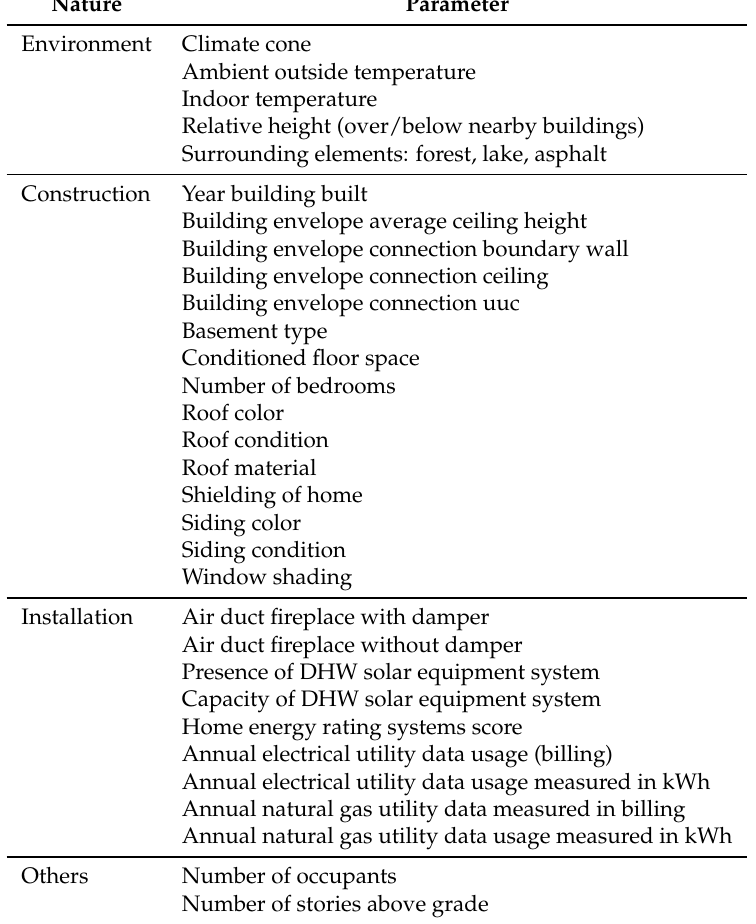
Table 6. Parameters used in the building thermal model.